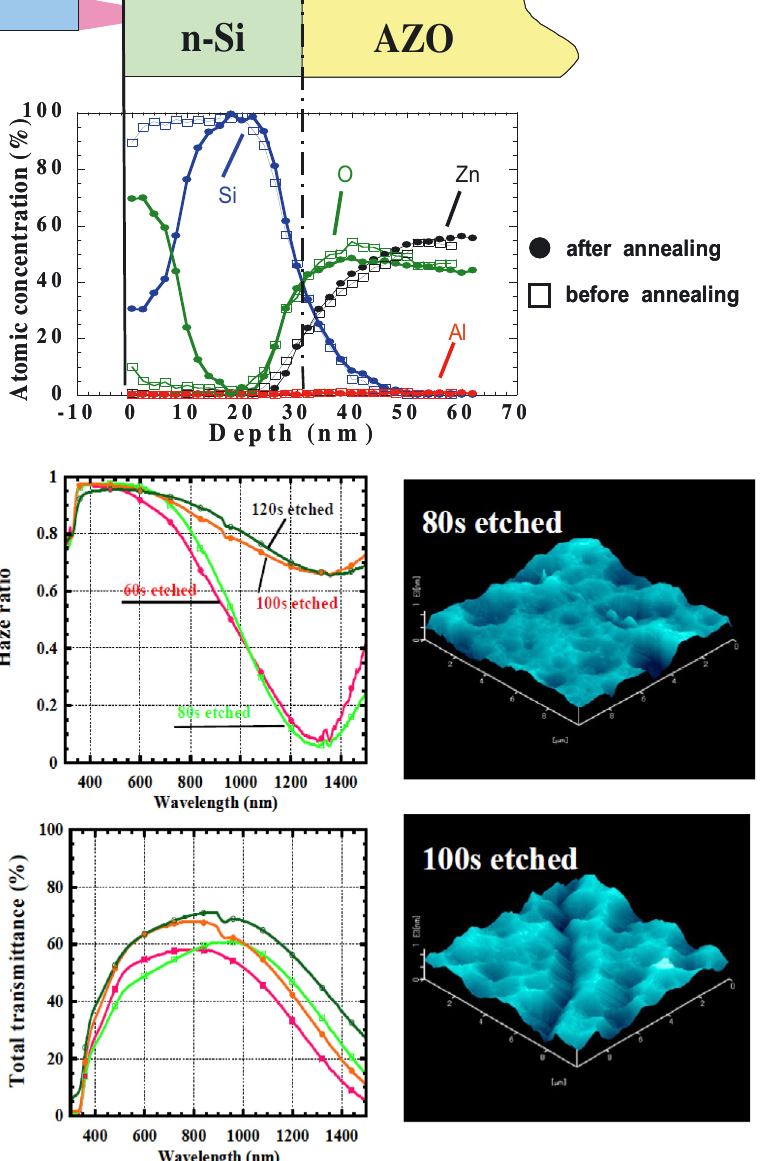
Total transmittance T total and haze spectra of TPJ-annealed AZO films with differ- ent surface morphology. The wet chemical etch- ing was conducted after TPJ annealing by a 0.5% HCl at different dipping times. The TPJ annealing was performed at a v sub of 25 mm/s and a T max of 650 ◦ C. The inset shows the AFM images of the 80 and 100 s chemically etched AZO